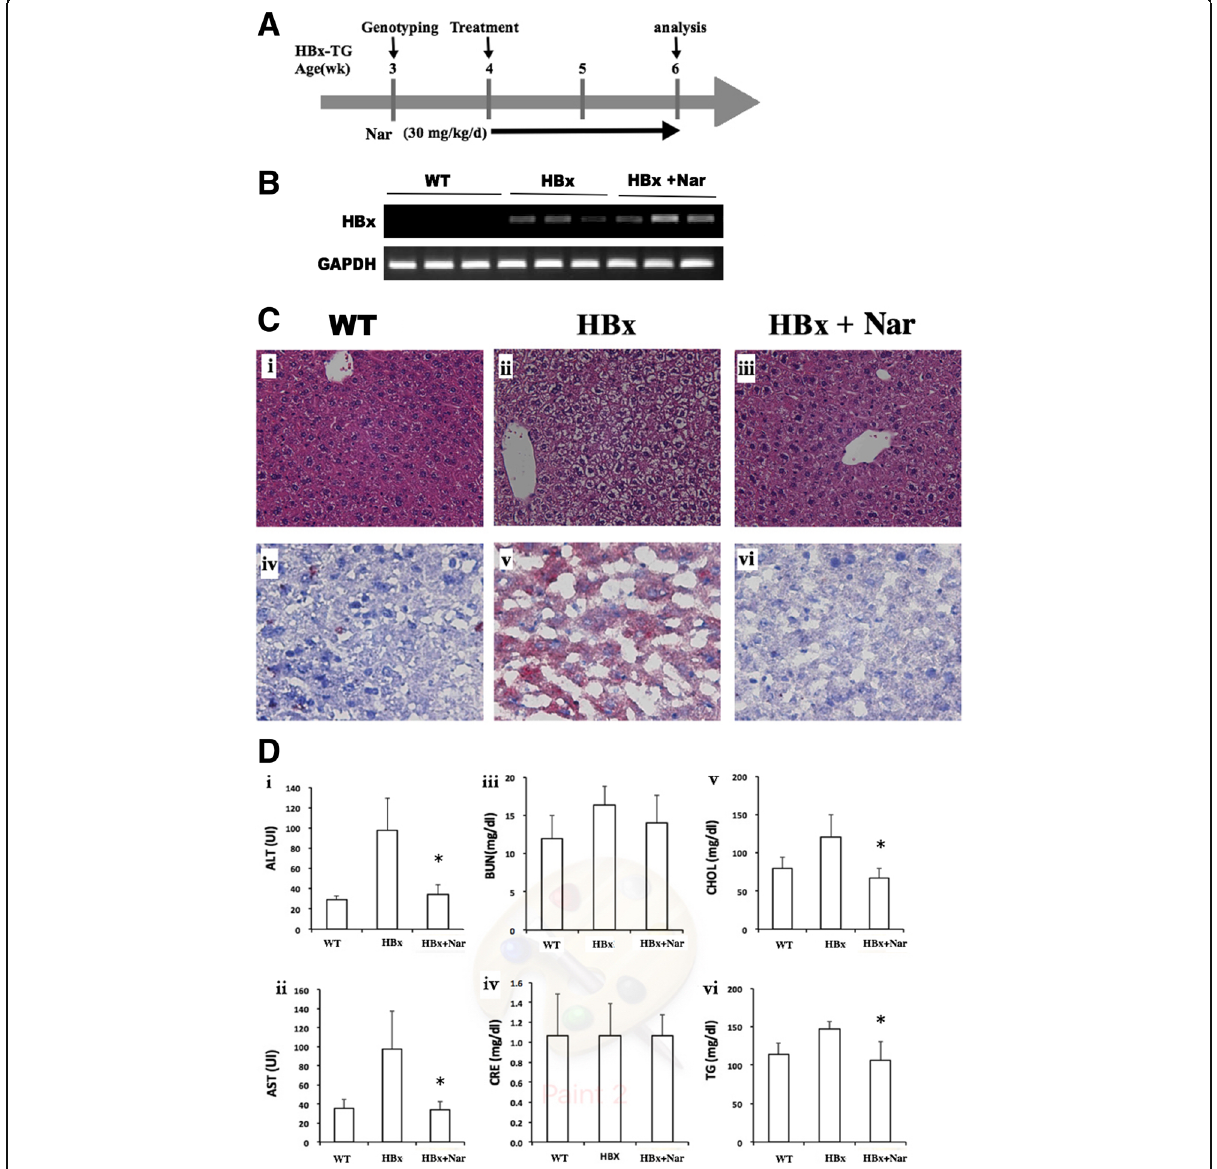
Fig. 1 Treatment with naringenin (Nar) reverses fatty liver and early-stage liver damage in HBx-transgenic mice. a Schematic timeline of the treatment protocol. Animals were genotyped at 3 weeks of age. Starting at 4 weeks of age, HBX-transgenic mice ( n =5 per group) were dosed by 14 days of once-daily oral gavage with Nar (30 mg/kg) or an equivalent volume of vehicle (phosphate-buffered saline, PBS); wild-type (WT) littermates ( n =5) were dosed on the same schedule with vehicle. b Representative micrographs of hematoxylin and eosin (H&E) – stained sections of liver sections from a vehicle-dosed WT mouse (i), a vehicle-dosed HBx-transgenic mouse (ii), and a Nar-dosed HBx-transgenic mouse (iii), or representative micrographs of Oil red-O – stained sections of liver sections from animals of the same groups [(iv), (v), and (vi), respectively]. Original magnification, H&E 200×, oil red-O staining, 400×. c The levels of serum parameters for liver function [alanine aminotransferase (ALT) (i) and aspartate aminotransferase AST (ii)], renal function [blood urea nitrogen (BUN) (iii) and creatinine (Cre) (iv)], and lipid chemistry [total cholesterol (CHOL) (v) and triglycerides (TG) (vi)] were measured in vehicle-dosed WT mice, vehicle-dosed HBx-transgenic mice, and Nar-dosed HBx-transgenic mice. Values are expressed as mean±SD. #, p <0.05 between vehicle-treated WT and HBx-transgenic mice, *, p <0.05 between HBx-transgenic vehicle- and Nar-treated